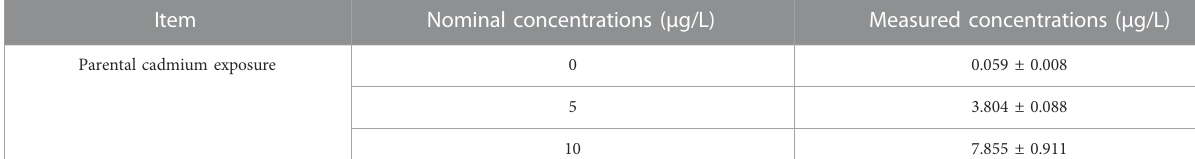
TABLE 1 The nominal and measured concentrations of Cd (inductively-coupled plasma mass spectrometry (ICP-MS) method) ( n = 3).